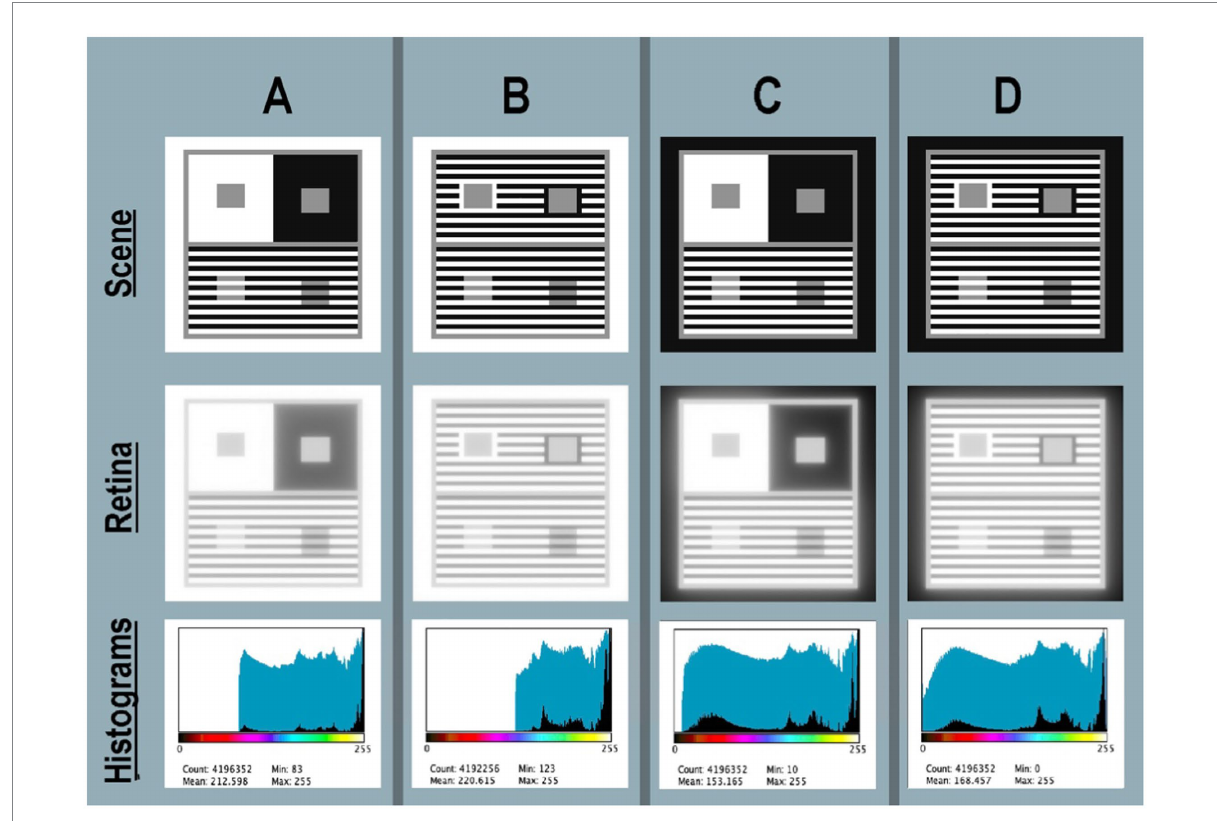
FIGURE 5 (A–D) Four Contrast + Assimilation targets: Scene (top-row) shows four Illusion scenes displayed individually on the computer screen < map.tif> ; Retina (middle-row) calculated pattern of light on receptors < retinal_contrast_log_grayscale> ; Histograms (bottom-row) linear (black fill) and log (blue fill) histograms of < retinal_contrast_log_grayscale> . Above the horizontal axis the color bar illustrates [ cmap.LUT ] pseudocolor mapping. All renditions used parameters [ log_range = 2.3 ], [ padding = replicate